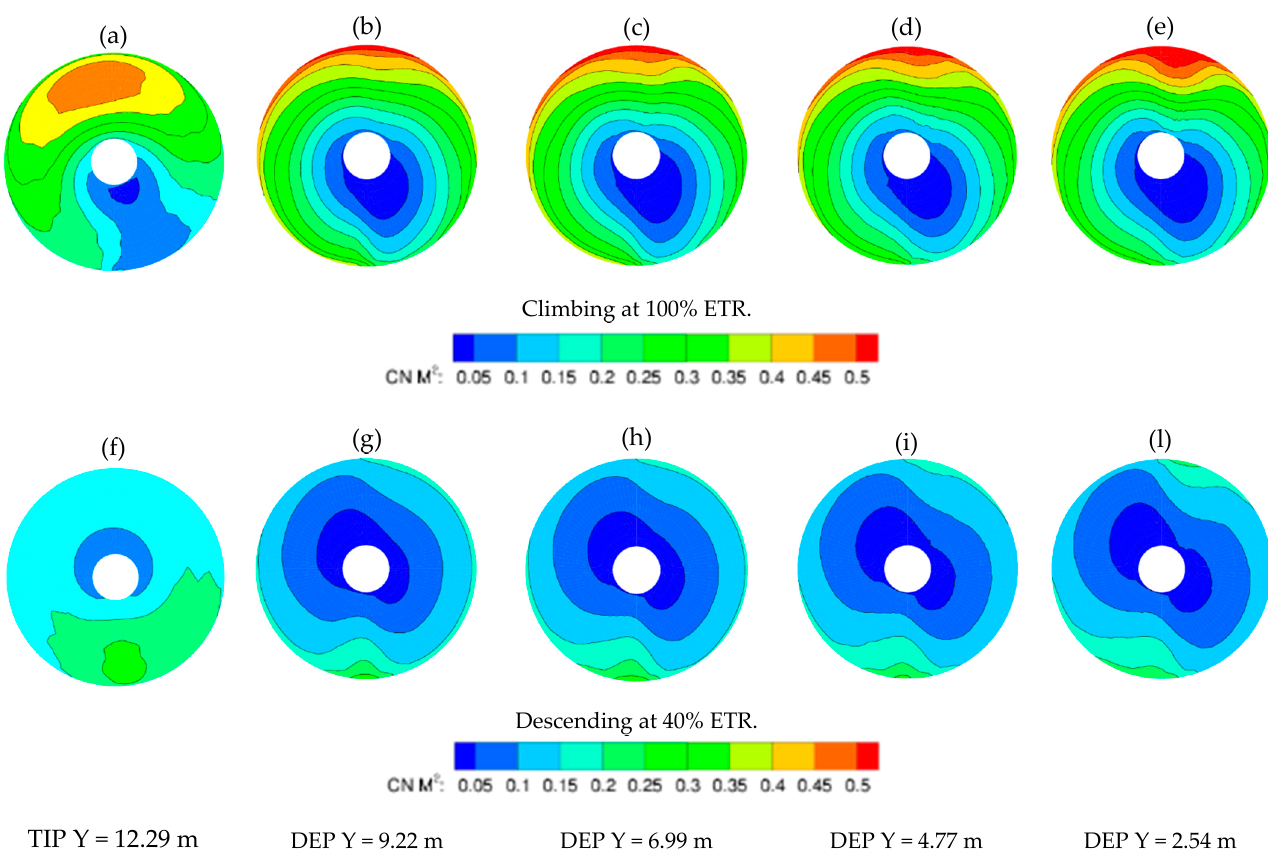
Figure 17. Motorization2—CN M 2 distribution on the propellers’ disks, starboard side. From ( a – e ), load on the disk from Tip to inner propellers, in Climb condition. From ( f – l ), same results in Descent flight.